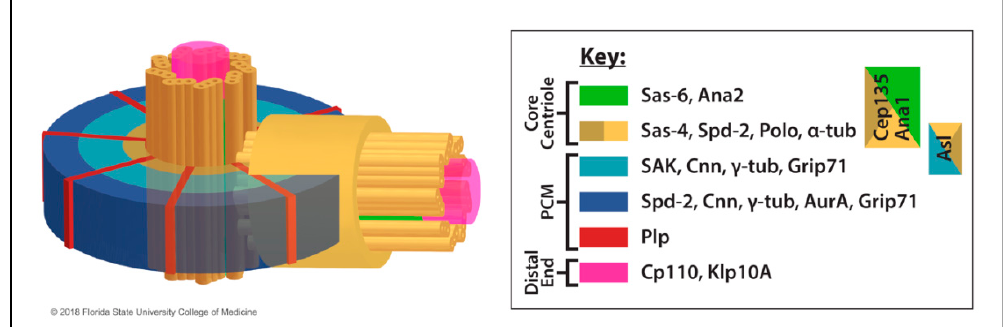
Figure 1. Structure of the Drosophila centrosome. The organization of several centriolar and pericentriolar material (PCM) proteins in the interphase centrosome. The mother centriole organizes PCM, shown as three layers, and maintains a tight association (engagement) with the daughter centriole. The figure is based on models presented in [16–18].